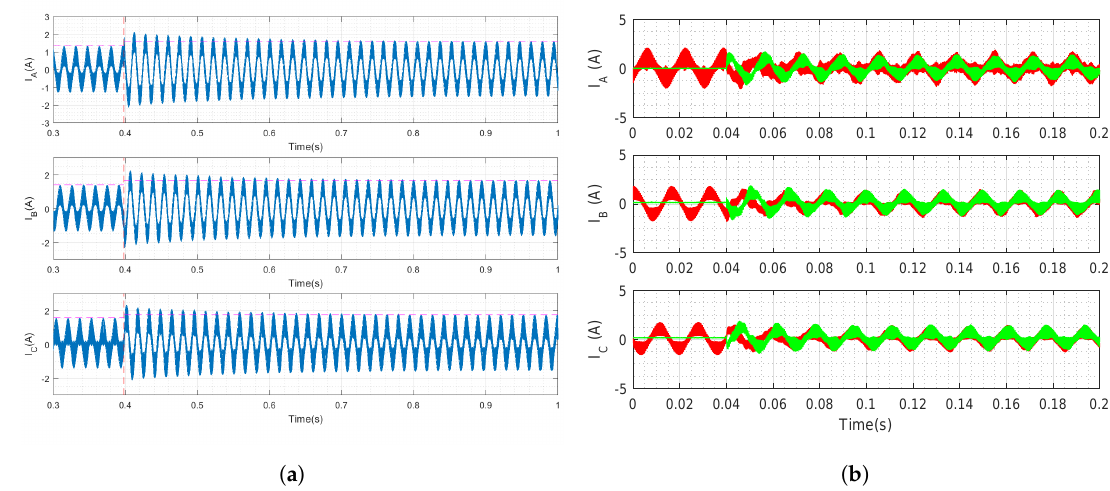
Figure 11. Experimental testing of a three phase voltage-sourced inverter which responds to step changes in load and synchronizes with another inverter. ( a ) Voltage-controlled inverter load resistance changes from 8 Ω to 2.66 Ω per phase resulting in transient response from the system with voltage and current overshoot. The DZO output then settles to nominal conditions. ( b ) Voltage-controlled inverter synchronizes when connected to another inverter.